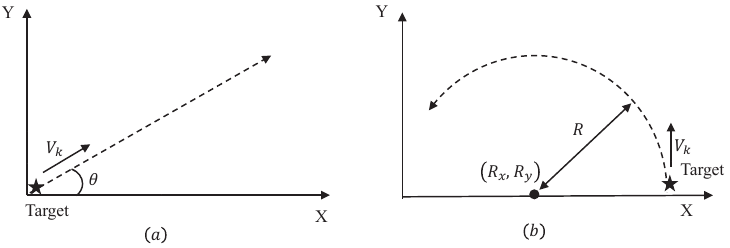
Figure 3. ( a ) target travels in a straight line along the direction θ ; ( b ) target travels along the circular road with the turning center ( R x , R y ) and the radius R .